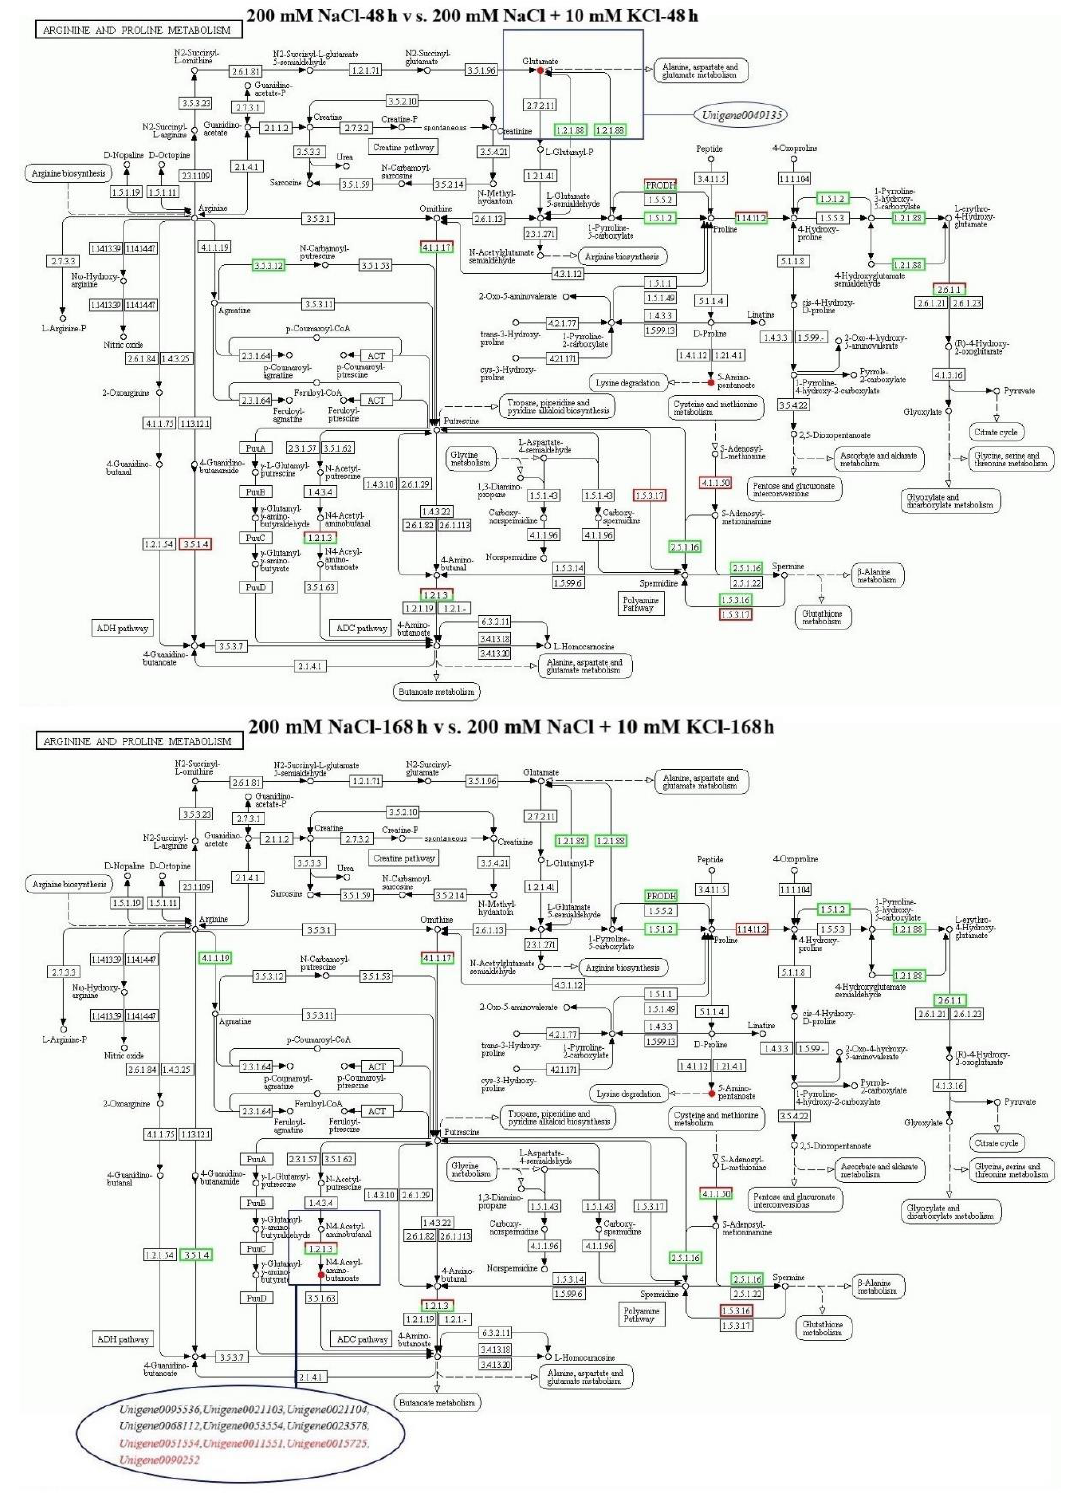
Figure 2. Analysis of the arginine and proline metabolic pathway: The changes in the annotated expression levels of DEGs and differential metabolites in the arginine and proline metabolic pathway, and the regulatory relationship between DEGs and differential metabolites in the 200 mM NaCl 48 h vs. 200 mM NaCl + 10 mM KCl 48 h and 200 mM NaCl 168 h vs. 200 mM NaCl + 10 mM KCl 168 h comparison groups. Note — Black: gene expression level is downregulated, metabolites are degraded; red: gene expression level is upregulated, metabolites are accumulated.